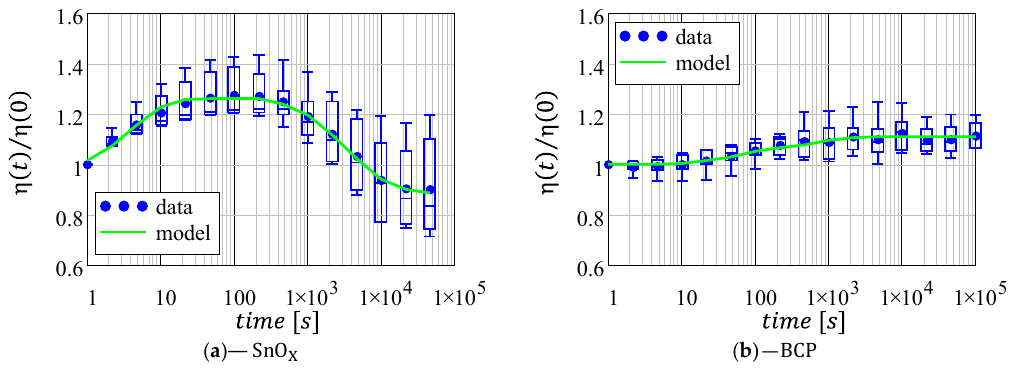
Figure 6. Normalized power conversion efficiency as a function of time for the two architectures under analysis: ( a ) SnO X -based cells; ( b ) BCP-based cells. Data fitting (green line) was computed using the mean values (blue circles) as a data-set. Plots are reported with the same axis a direct comparison. Full ‐ scale axes are reported in Supplementary Figure S5.